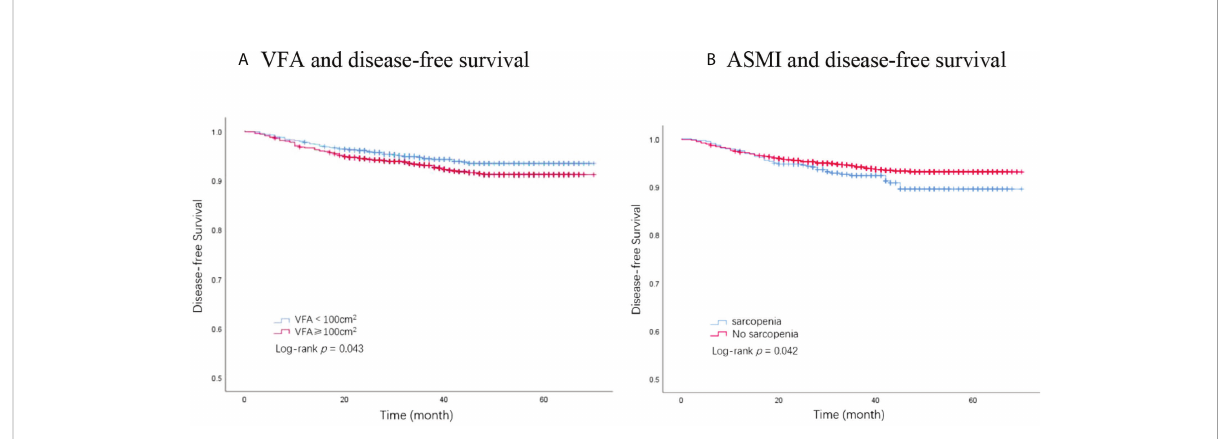
FIGURE 1 Kaplan – Meier plot of disease-free survival by VFA and ASMI. (A) VFA and disease-free survival. (B) ASMI and disease-free survival. VFA, visceral fat area; ASMI, appendicular skeletal muscle